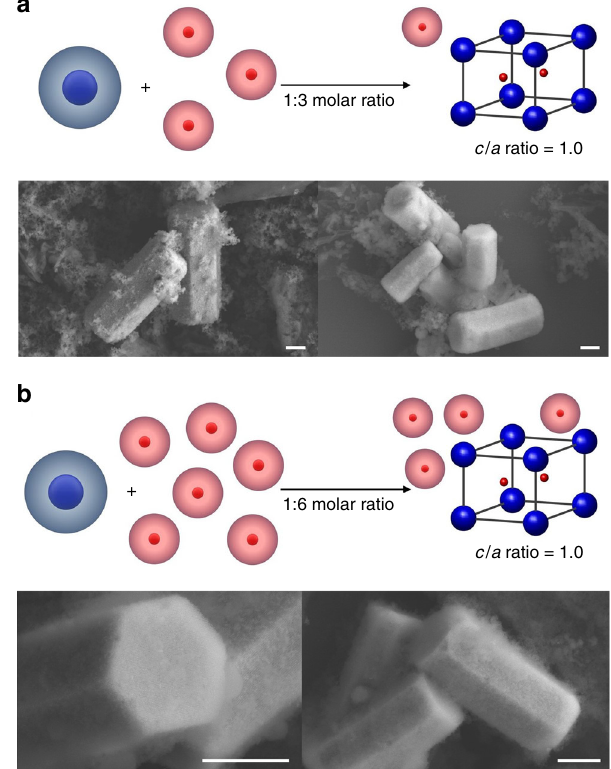
Fig. 4 Hexagonal prisms produced upon addition of off-stoichiometric ratios of PAEs. a , b Scheme and SEM images of hexagonal prism microcrystals when different molar ratios of A:B particles, ( a ) 1:3 and b 1:6, were added. In both cases, AB 2 lattices have a similar c / a ratio to the one formed using a stoichiometric ratio of PAEs (1:2). Scale bars are 1 μ